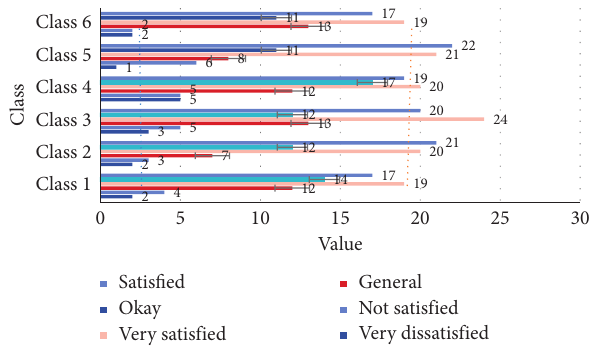
Figure 7: Multimedia teaching satisfaction. Table 6: Traditional teaching satisfaction.